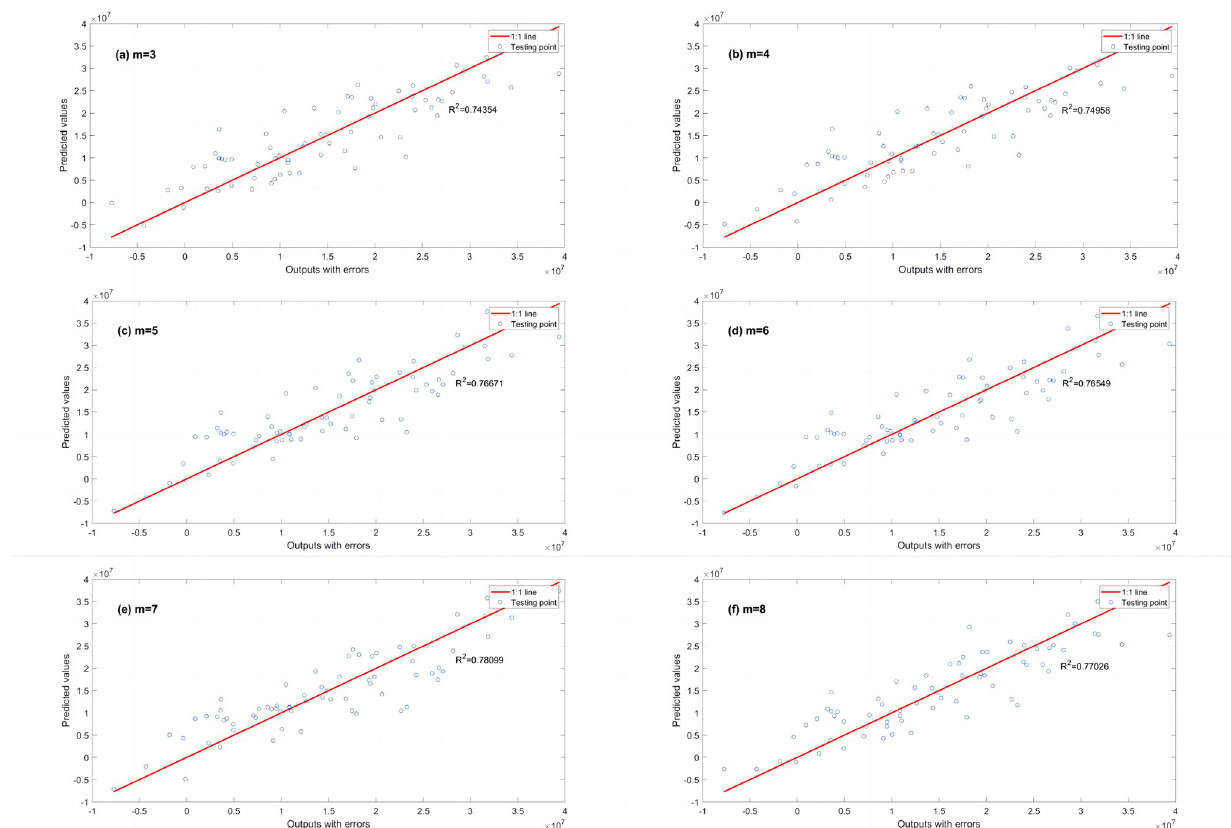
Fig 17. R 2 calculated by EPR with L1RM in dataset 4. (a) m = 3, (b) m = 4, (c) m = 5, (d) m = 6, (e) m = 7 and (f) m = 8.